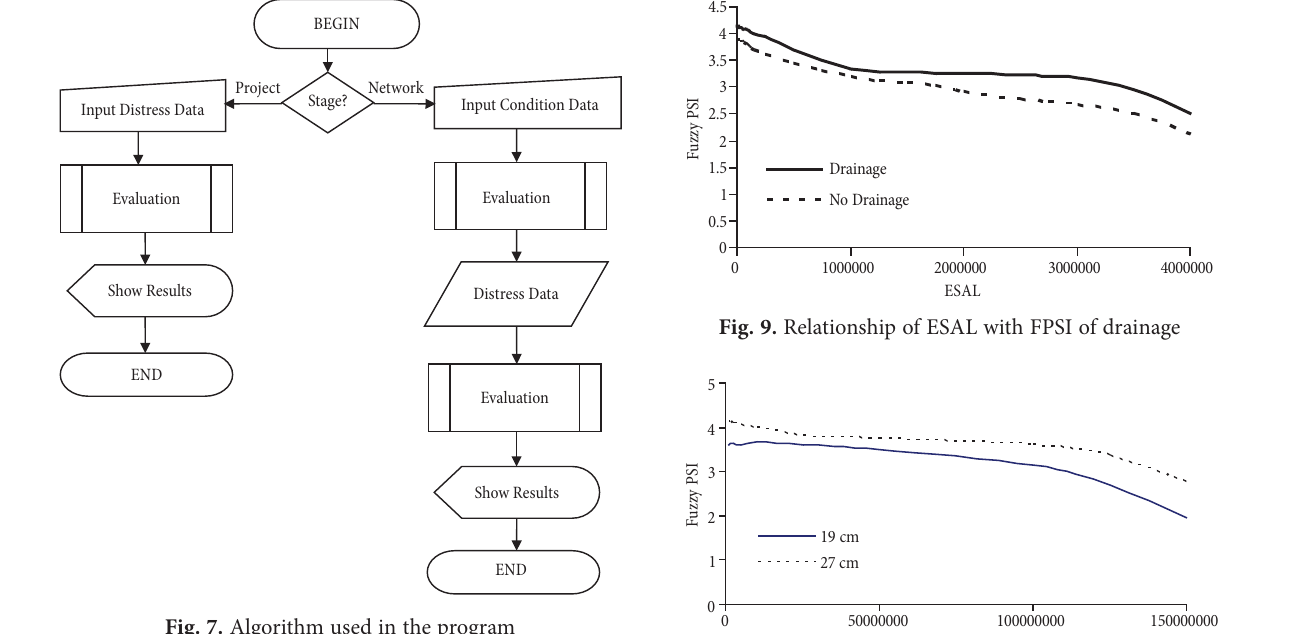
Fig. 7. Algorithm used in the program